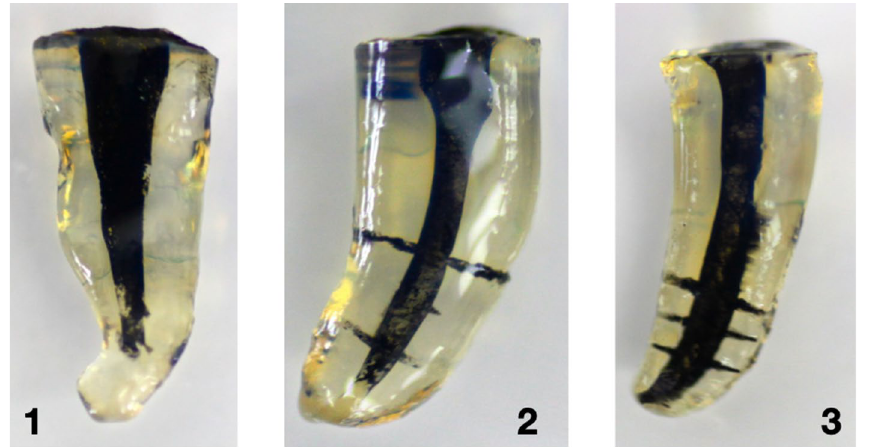
Figure 7. Representative images of curved canals. 1 PPI, 2 PUI, 3 CANUI.